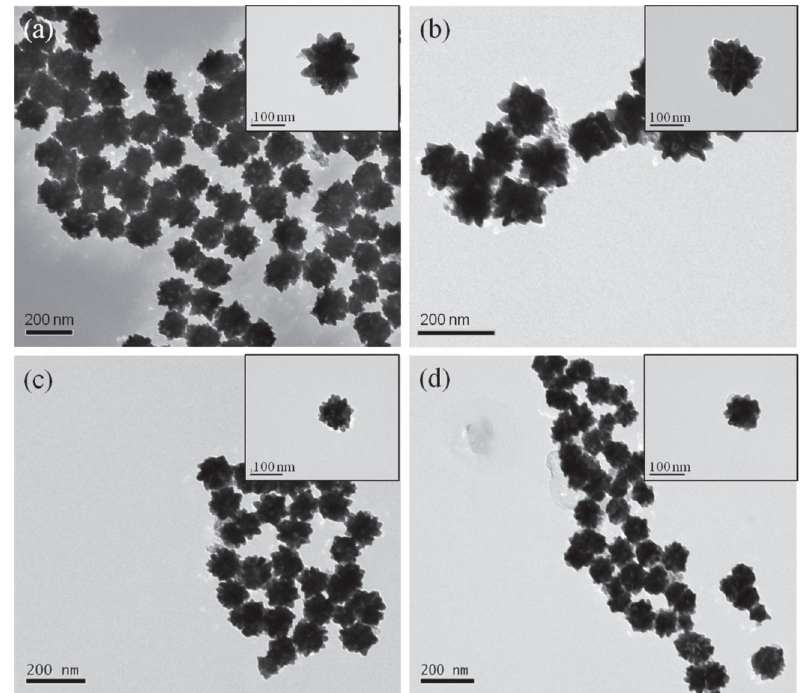
Figure 4. TEM (transmission electron microscopy) images illustrating the size dependence of the supramolecular spiky nanostructures on the amount of smooth Fe 3 O 4 @Au seeds initially introduced ( a ) 4.5 nM; ( b ) 8.9 nM; ( c ) 13.2 nM; ( d ) 17.5 nM. Reprinted with permission from [33]. Copyright WILEY-VCH, 2013.